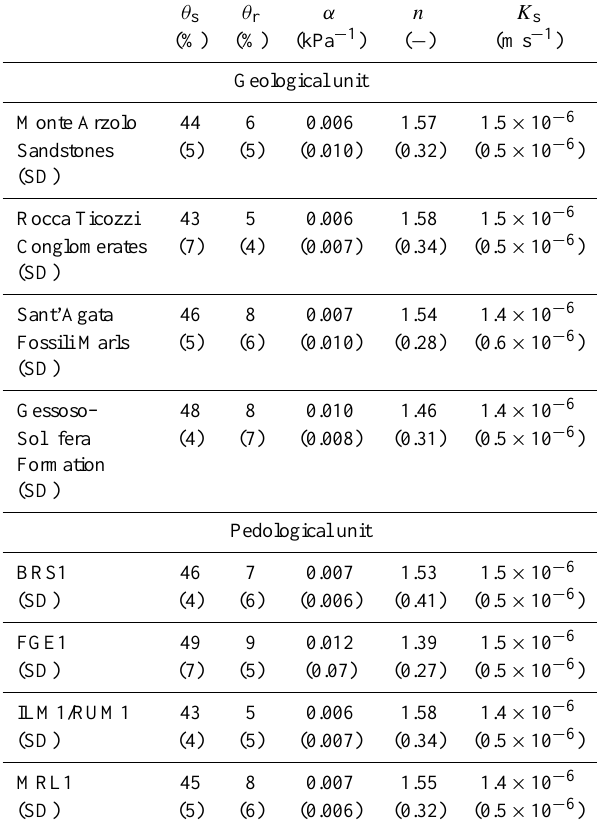
Table 4. Mean and standard deviation (SD) values of hydrological properties of the unit mapping of the soils of the study area. The SD values are in